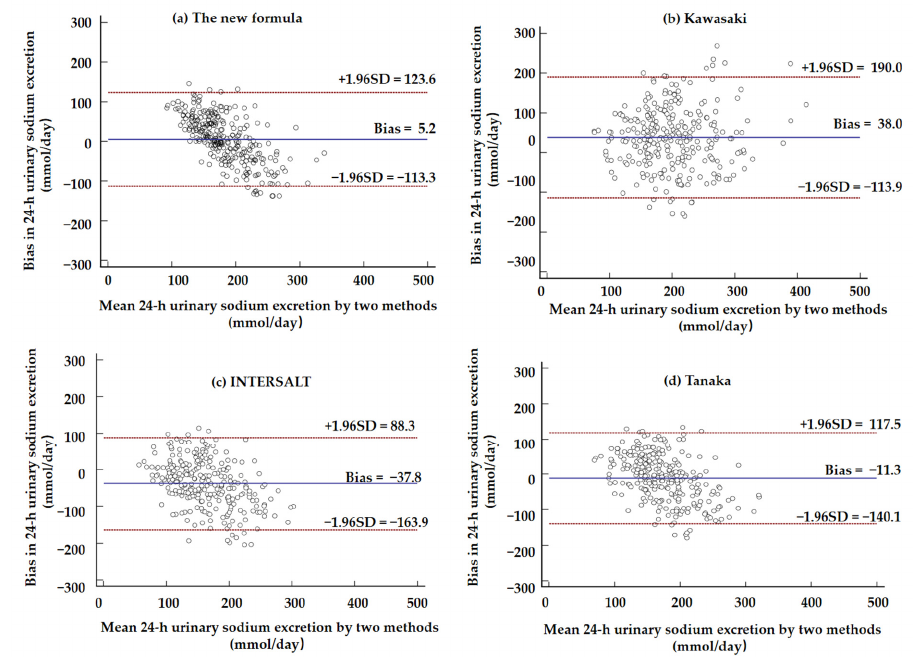
Figure 2. Bland–Altman plots showing the difference in 24 h urinary sodium excretion (24UNaV) between measured and estimated values from the new formula (a), Kawasaki formula (b), INTERSALT formula (c), and Tanaka formula ( d ). The difference was calculated as the estimated values minus the measured values. The middle line is the mean bias, while the upper and lower dashed lines are the upper and lower limits,